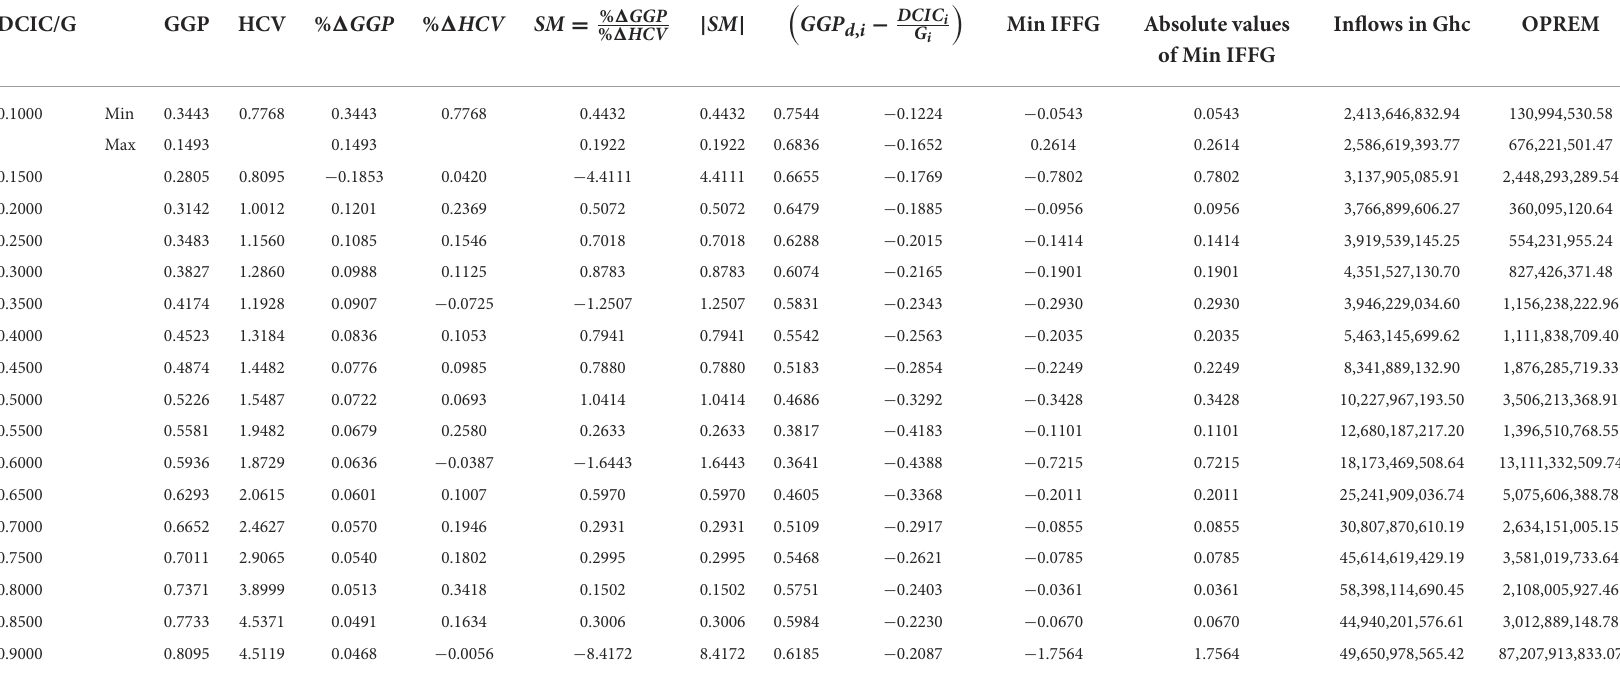
TABLE 1C Optimal Reserves for different critical values given exchange rate